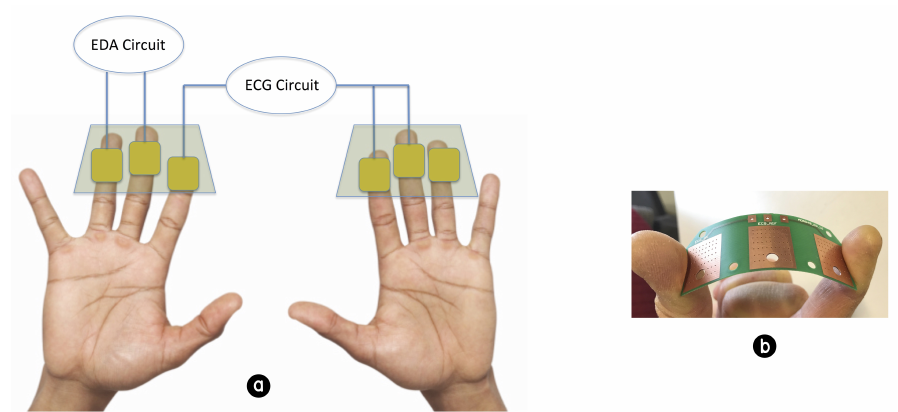
Figure 3. Schema of the acquisition patches. In (a) is represented the working principle of the finger electrodes, while in (b) is shown the developed patch and its flexibility characteristics; EDA: Electro Dermal Activity; ECG: